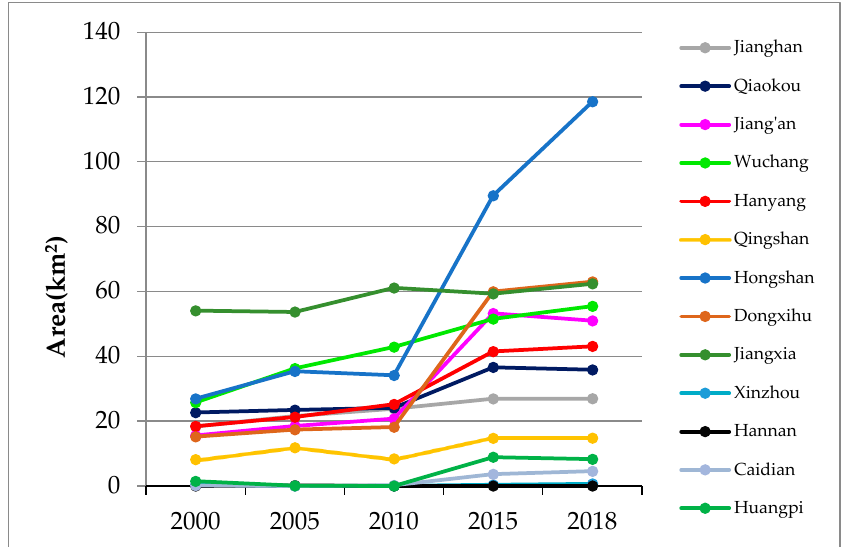
Figure 10. Changes in area of high risk and highest risk in the 13 districts from 2000 to 2018.